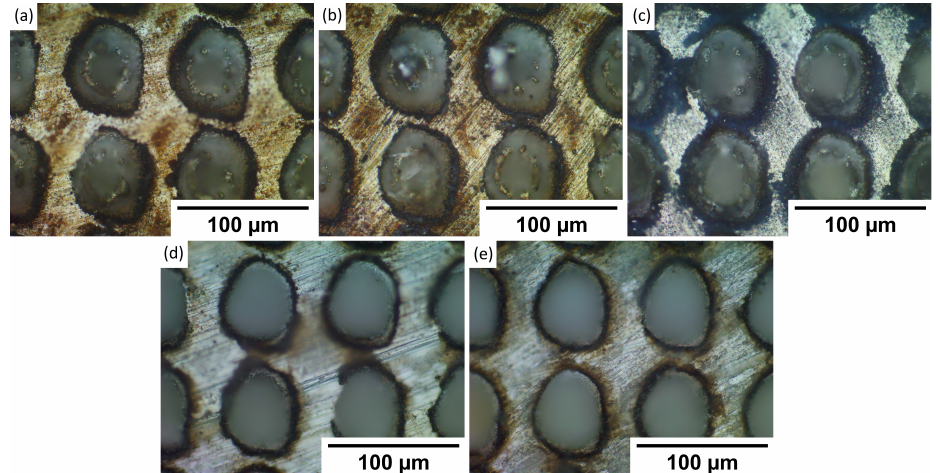
Figure 2. Microscope pictures, with × 50 magnification of each sample dimple texture. ( a )—17- 4PH stainless steel, ( b )—PH13 stainless steel, ( c )—Ti6Al4V titanium, ( d )—2024 T3 aluminum, ( e )— 7050